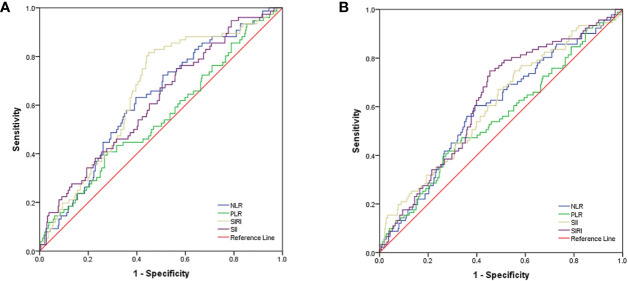
(A) ROC curve analysis for optimal cut-off value of NLR, PLR, SII and SIRI for PFS. (B) ROC curve analysis for optimal cut-off value of NLR, PLR, SII and SIRI for OS. ROC, receiver operating characteristic; PFS, progression free survival; OS, overall survival; NLR, neutrophil-to-lymphocyte ratio; PLR, platelet-to-lymphocyte ratio; SII, systemic immune inflammation index; SIRI, systemic inflammation response index.